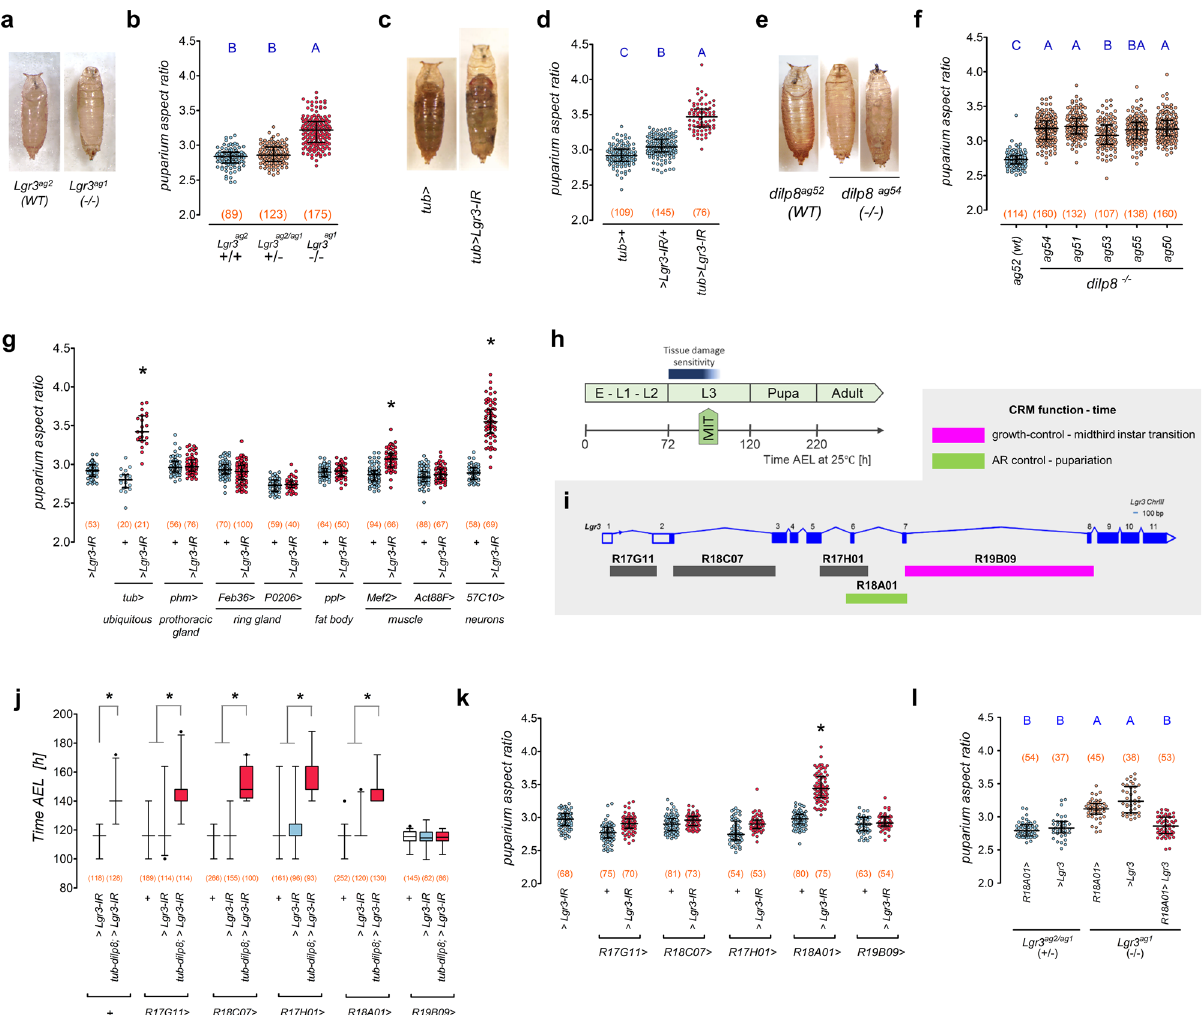
Fig. 1 Puparium morphogenesis requires Dilp8-Lgr3 signaling in neurons. a Representative photos of puparia from the depicted genotypes. b Lgr3 mutation increases puparium aspect ratio (AR). Shown are dot plots of puparium AR. c Representative photos of puparia from the depicted genotypes. d Ubiquitous Lgr3 knockdown with tubulin-GAL4 ( tub > ) ( tub > Lgr3-IR ) increases puparium AR. Shown are dot plots of puparium AR. e Representative photos of puparia from the depicted genotypes. f dilp8 mutation increases puparium AR. Shown are dot plots of puparium AR. g Pan-neuronal Lgr3 knockdown ( 57C10 > ) increases puparium AR similarly to ubiquitous knockdown ( tub > ). Shown are dot plots of puparium AR. h Sensitivity to tissue- damage-induced Dilp8 occurs before the midthird instar transition (MIT). Time after egg laying (AEL). i Lgr3 locus scheme with its cis-regulatory modules (CRM) and known activities. j tub-dilp8- induced developmental delay rescue by R19B09 > Lgr3-IR . Box plots showing pupariation time. k Knockdown of Lgr3 in R18A01, but not in R19B09 neurons, increases the puparium AR. Shown are dot plots of puparium AR. l Rescue of the puparium AR defect of Lgr3 ag1 mutants by R18A01 > Lgr3 . Shown are dot plots of puparium AR. Statistics (full details in Supplementary Table 2): b , d , f , g , k , l Dots: one animal. Horizontal bar, median. Error bars: 25-75% percentiles. j Box, 25 – 75%; horizontal bar, median; whiskers, 5-95%. Dots, outliers. b , d , f , l Same blue letter, P >